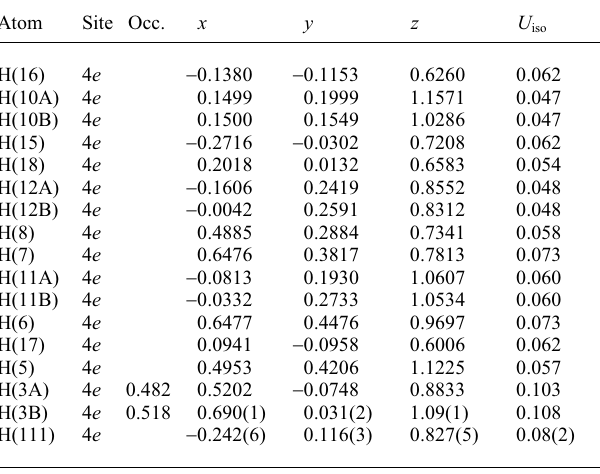
Table 2. Atomic coordinates and displacement parameters (in Å 2 )